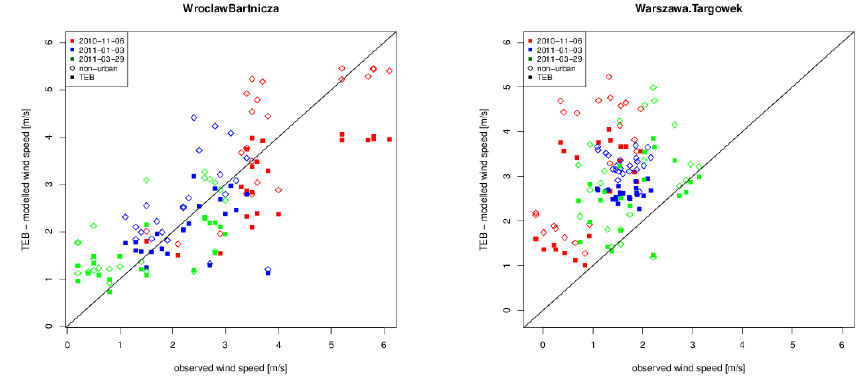
Fig. 18. Near surface wind speed measured at Wroclaw-Bartnicza and Warsaw-Targowek air-quality monitoring stations and calculated with the GEM-AQ model. Full colour with the TEB parameterization and the reference case outlined colour, red: 6 th November 2010; blue: 3 rd January 2011; green: 29 th March 2011.